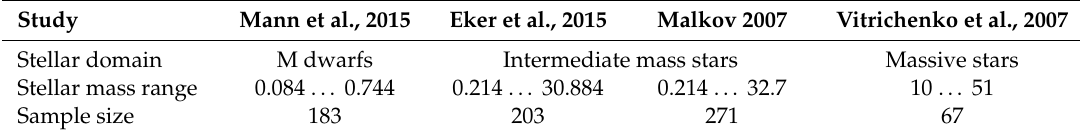
Table A2. Four data sets of stellar properties were included in a composite sample used to estimate the generalized relation between a star’s mass and bolometric luminosity. Each set provides a reference table of basic parameters including star mass, radius, effective surface temperature, bolometric luminosity, or